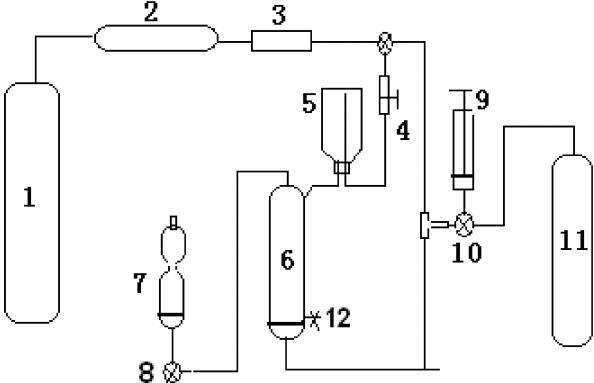
Figure 1. The purge-and-trap system for the determination of dis- solved nitric oxide in seawater. The components include N2 gas (1), deoxygenation tube (2), glass rotameter (3), 2-port valve (4), sam- ple vial (5), degassing column (6), reaction chamber (7), 3-port valves (8 and 10), gas-tight syringe (9), NO standard gas (11), and drain port